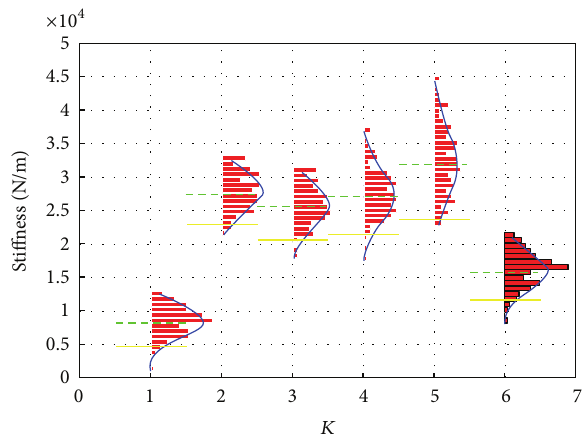
Figure 6: Control chart for identified stiffness calculated from pretest measurements.